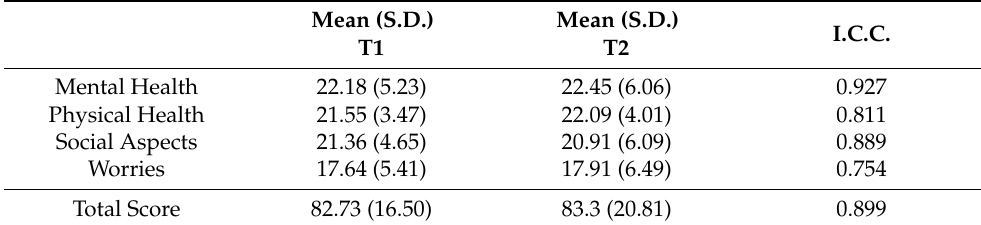
Table 1. Reliability of the instrument and factors of the ASDPCA-QoL ( n = 11).